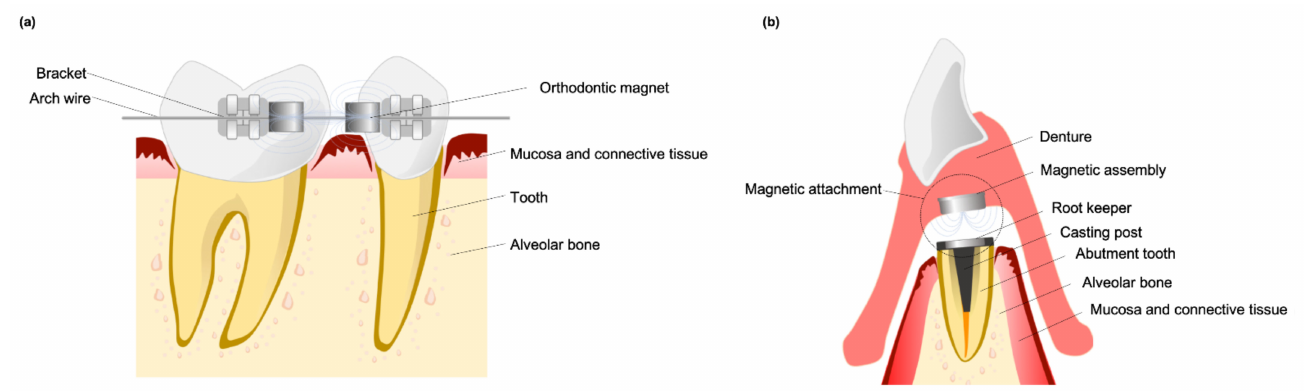
Figure 1. Magnets used in dentistry for ( a ) orthodontic tooth movement and ( b ) denture